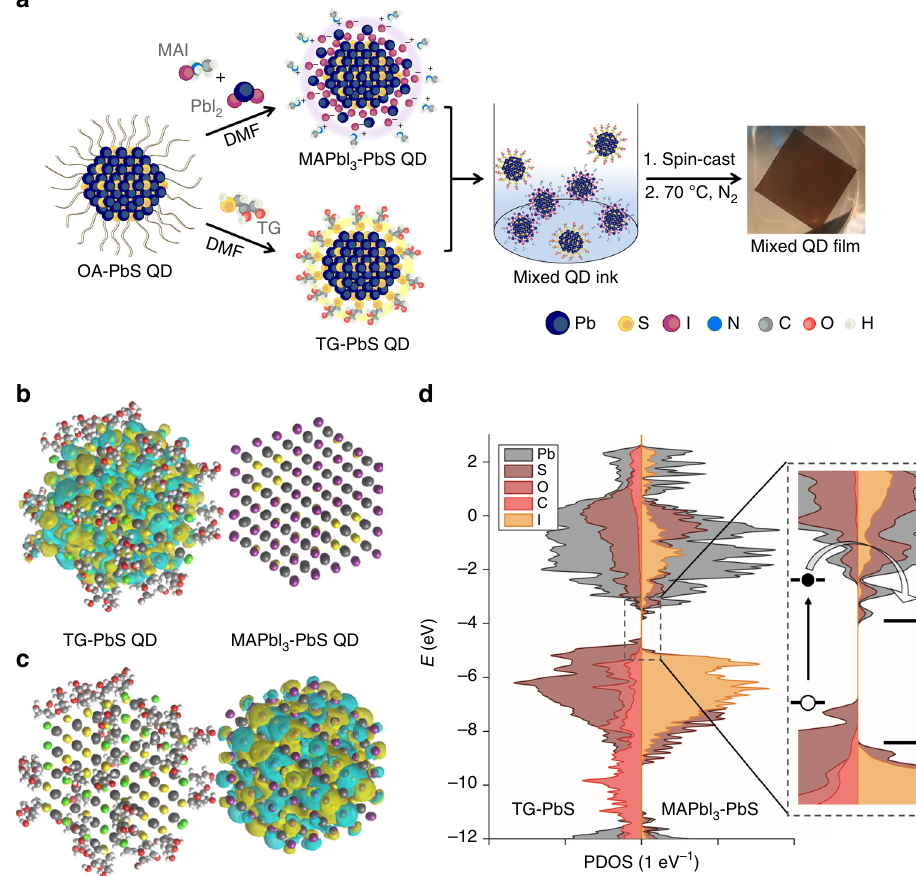
Fig. 1 Preparation of mixed-quantum-dot solids using solution ligand exchange. a Schematic of the solution ligand exchange process. b Calculated HOMO and c LUMO states of two coupled dots, showing charge transfer between MAPbI 3 - and TG-capped QDs in the mixed fi lm. d Projected density of states demonstrate the offset of the band position between MAPbI 3 - and TG-capped